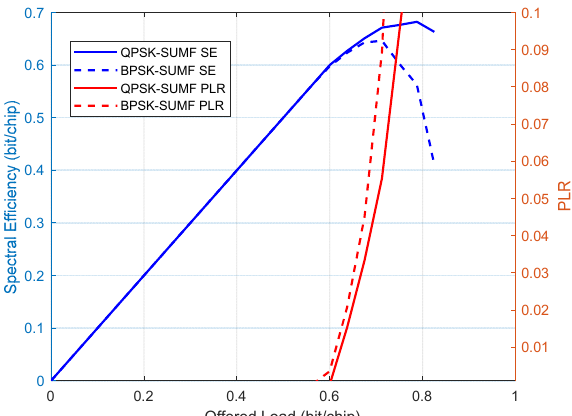
Figure 16. SE and PLR of QPSK with SUMF vs. BPSK with SUMF, minimum C / N = 0 dB and power spreading 3 dB.